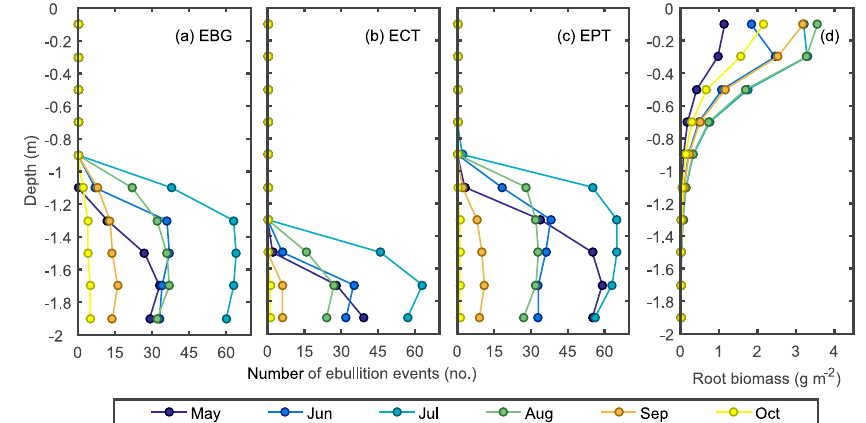
Figure 1. Number of ebullition events at different months and depths (a–c) and distribution of plant roots under the water table (d) . During other months (November–April) only 1% of all ebullition events took place and thus data from those months are not shown.